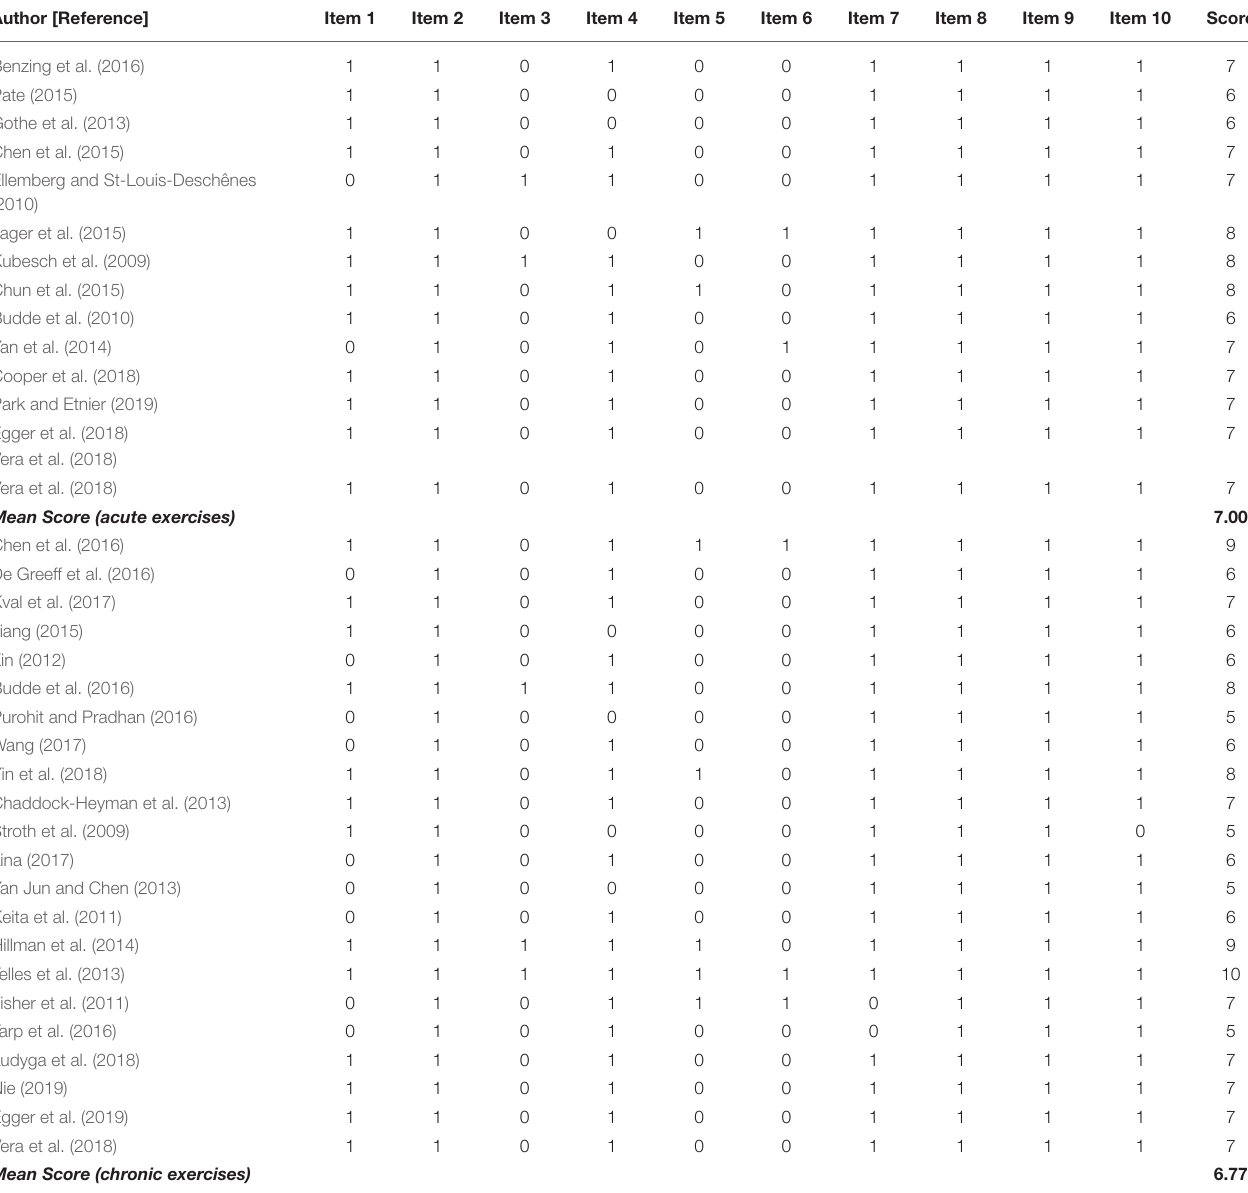
TABLE 3 | Physiotherapy Evidence Database Scale (PEDro) of the included randomized controlled trials (acute exercises and chronic